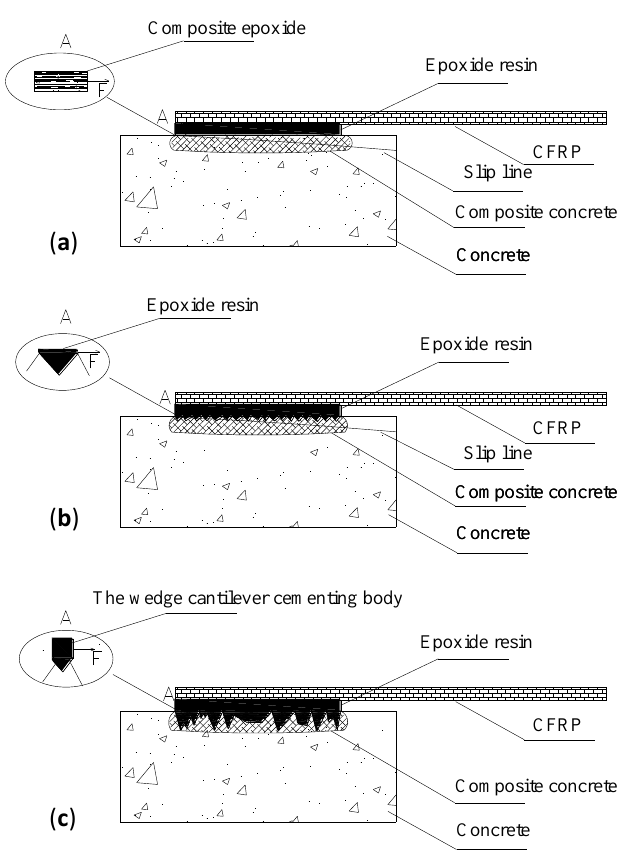
Figure 8. Different interface bond mechanisms. ( a) Interface a: f0; ( b ) Interface b: f1-f2; ( c ) Interface c: (f3–f5).